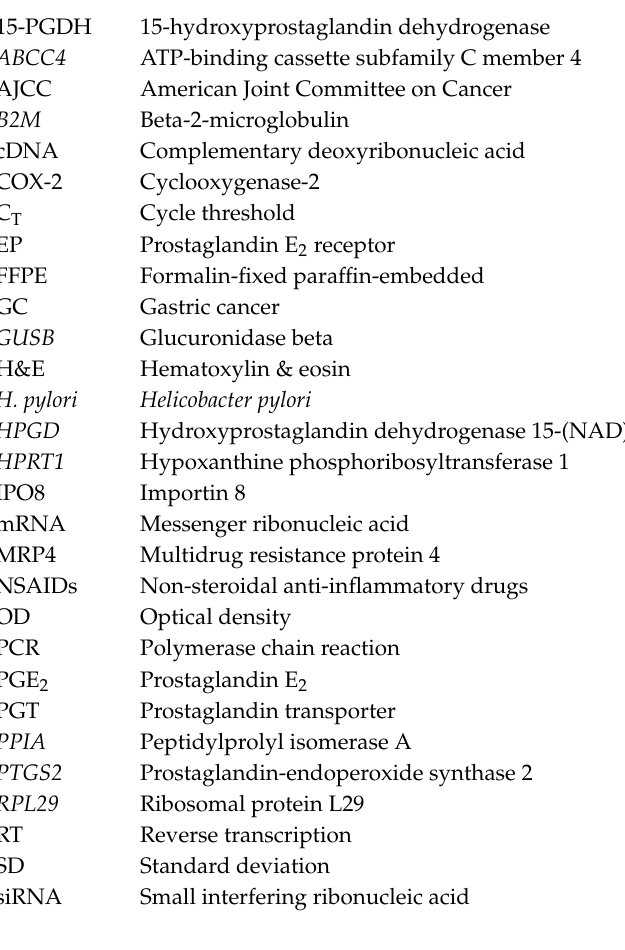
Figure S1. mRNA expression across GC stages. Table S1. Stability expression values for normalization of GC and GN samples from NormFinder and GeNorm